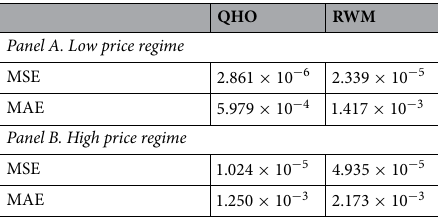
Table 6. Prediction errors of the log return distributions of Bitcoin derived from the QHO and RWM. Each estimated value is calculated based on the daily interval.